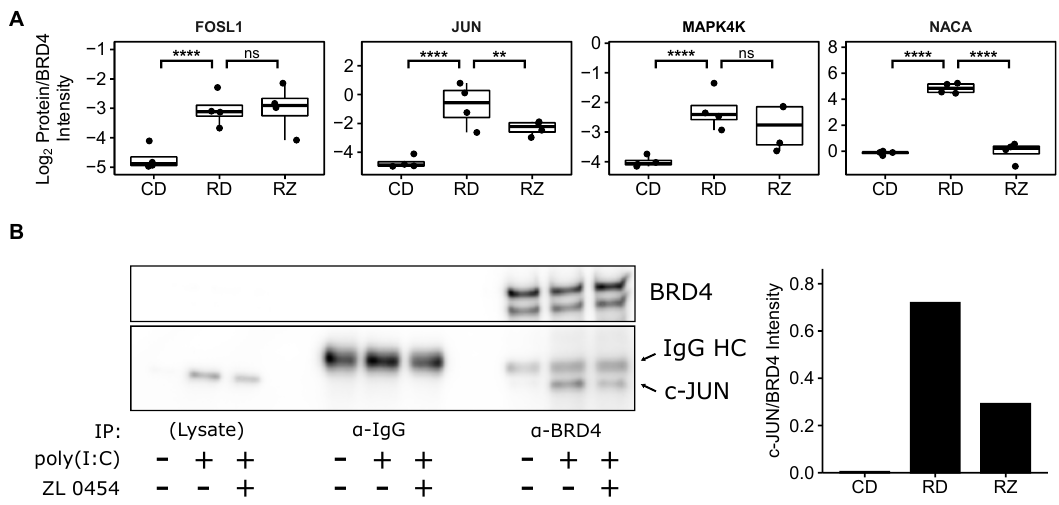
Figure 6. BRD4 recruits the AP1 transcription factor complex during RSV-infection. ( A ) Protein abundance boxplots of AP1 complex members and related proteins. Boxplots represent n = 4 biological replicates per experimental group. Each data point represents the mean of n = 2 technical replicates. ** P adj < 0.01; **** P adj < 0.0001 . ( B ) Confirmatory western blot and densitometric quantitation, demonstrating that TLR3-induced inflammation in hSAECs triggers the BRD4/c-JUN interaction in a bromodomain-sensitive manner. (+/ − ) indicates the presence or absence of the respective compound in a given lane. “IgG HC” refers to the anti-BRD4 antibody heavy